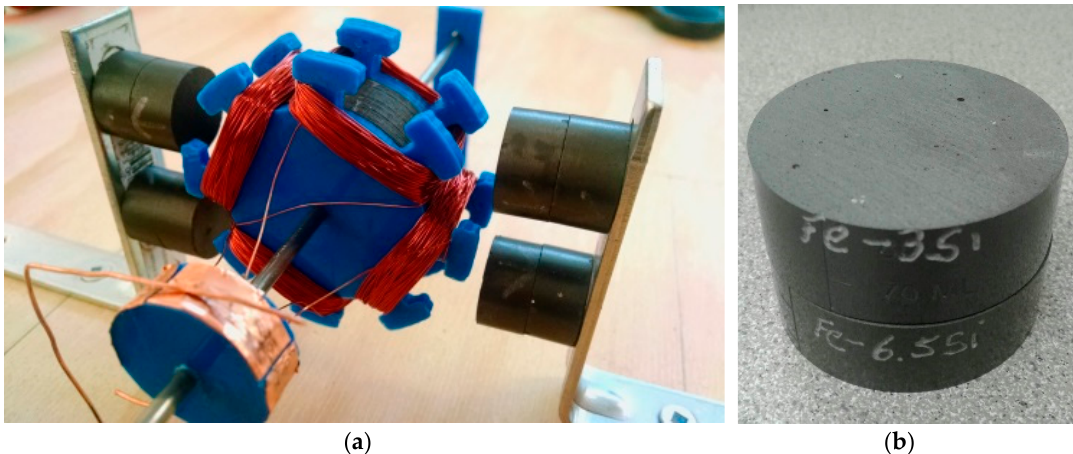
Figure 3. ( a ) FDM-printed rotor of Fe particles embedded in a PLA matrix with 50:50 by weight; ( b ) cold-spray additively manufactured Fe–3%Si particles embedded in PLA matrix with 50:50 by volume. We then FDM-printed a closed-magnetic-circuit stator with a redesigned rotor comprised of the same ProtoPasta magnetic PLA (Figure 4).